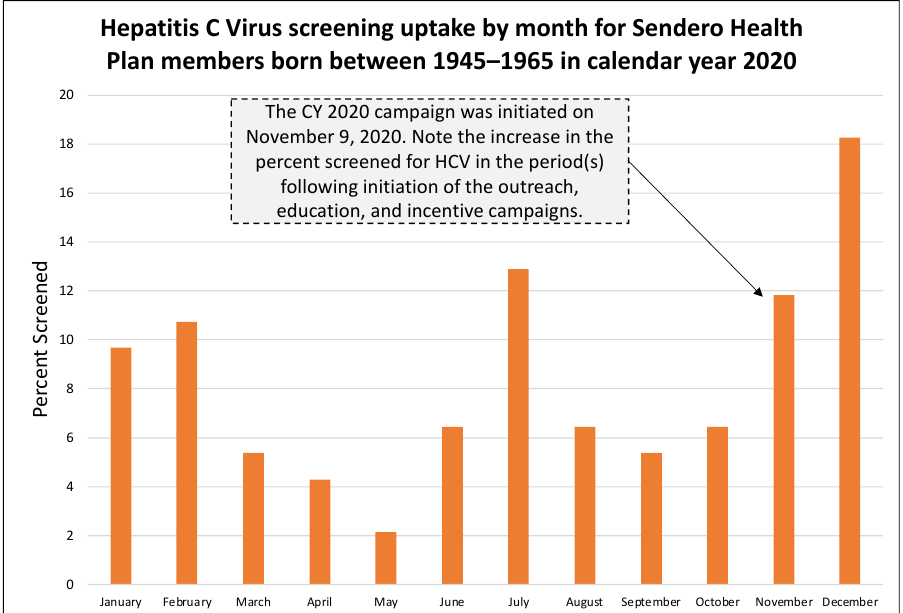
Figure 2. Hepatitis C Virus uptake by month for Sendero members born between 1945 – 1965 in cal- endar year 2020.